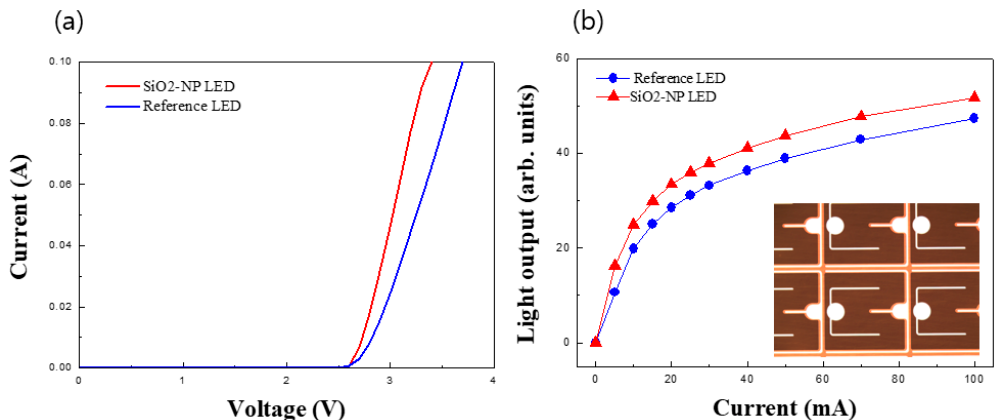
Figure 3. Device characterizations of ( a ) current-voltage (I-V) curve and ( b ) optical output (L-I) curve (Experimental result).